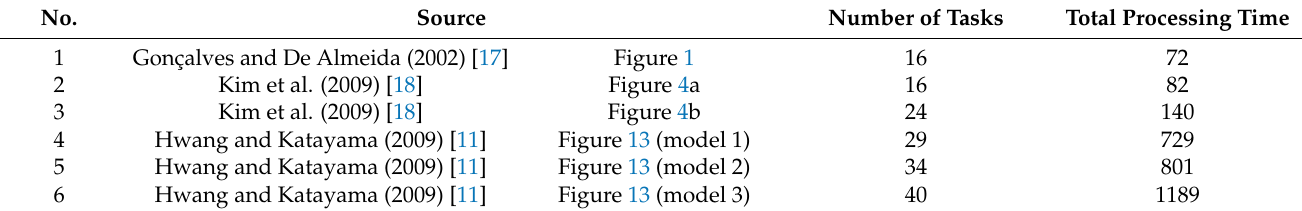
Table 5. Summary of larger problems.